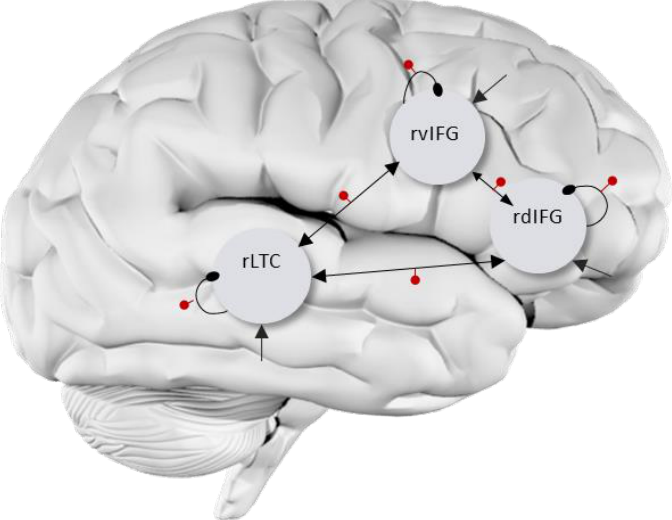
Figure 1. RH DCM full model. Driving inputs (C matrix) are marked by straight arrows into each VOI. Intrinsic self-connections are marked by curved round-end lines. Extrinsic (between-regions) connections are marked by straight arrows between regions. All connections were switched on in both A (all arrows) and B matrices (arrows with red dot) for both phonological and semantic tasks. The bilateral model was similar, with mirror architecture in the left hemisphere, as well as three homotopic connections between hemispheres switched on in A and B matrices. Table 3. Percent of explained variance by the DCM. The average [and range] per run across partici- pants are presented.